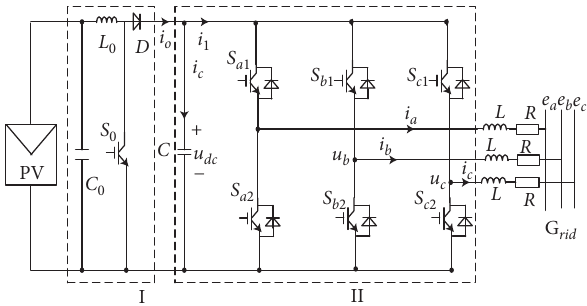
Figure 1: Two-stage PV grid-connected inverter topology.